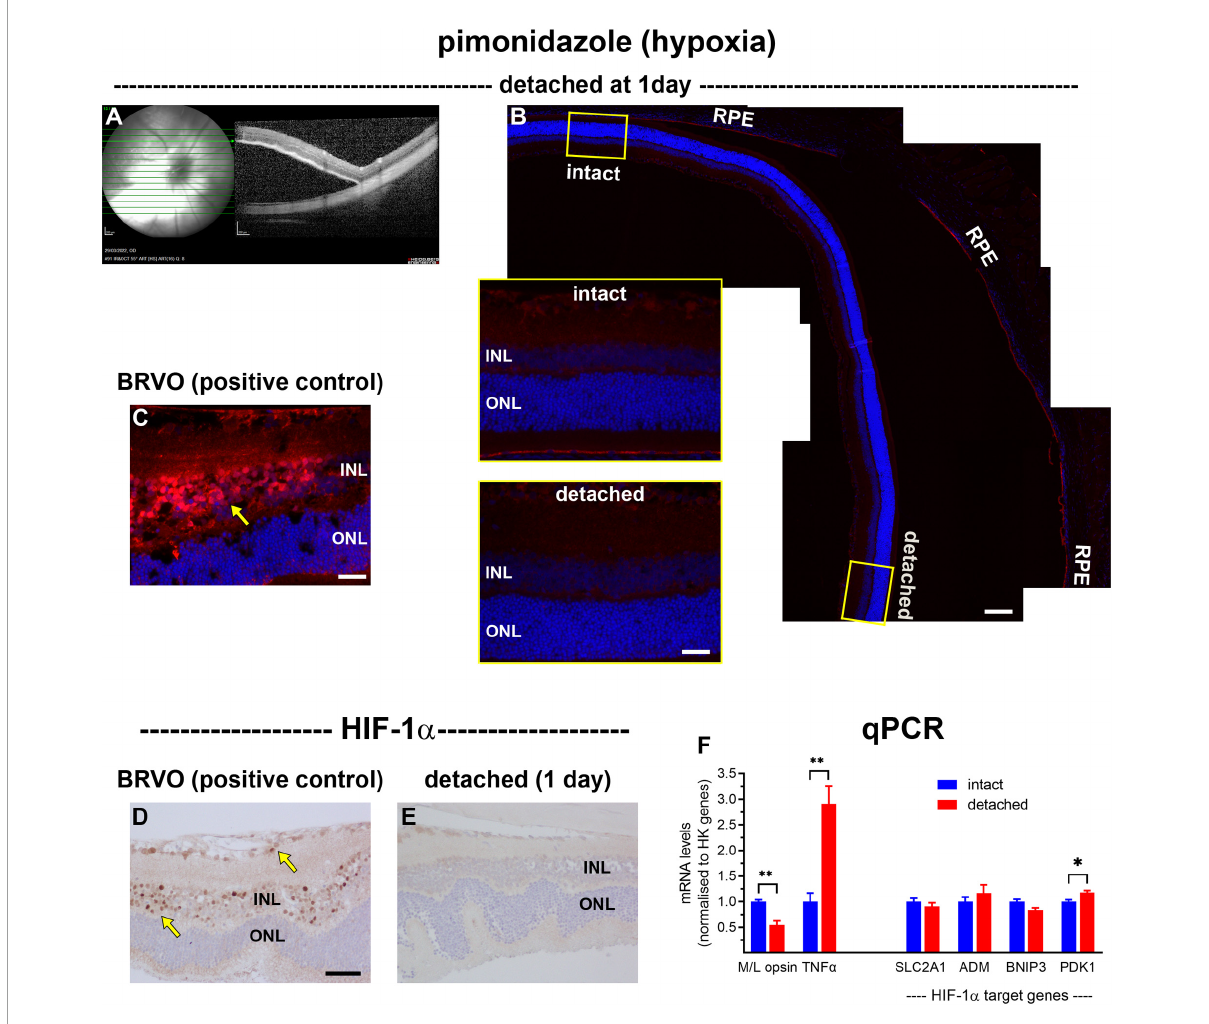
FIGURE1 Lack of hypoxia, HIF-1 α accumulation, and HIF-1 α target gene upregulation following retinal detachment. (A) Visualisation of representative retinal detachment at 1 day by fundus imaging and SD-OCT. (B,C) Representative images of pimonidazole staining (red, arrow) in retinas subjected to experimental detachment or branch retinal vein occlusion (BRVO). (D,E) Representative images of HIF-1 α immunolabelling in retinas subjected to experimental detachment or BRVO (arrows). Scale bars: (B) (overview) = 120 µ m; (B) inset, (C) = 30 µ m; (D,E) = 60 µ m. INL, inner nuclear layer; ONL, outer nuclear layer; RPE, retinal pigment epithelium. (F) Quantification of various mRNA levels at 1 day after detachment. Values (mean ± SEM) are normalised to a pool of two housekeeping genes and expressed as % of the intact group. * P < 0 . 05, ∗∗ P < 0.01 by Student’s unpaired t -test followed by modified Bonferroni